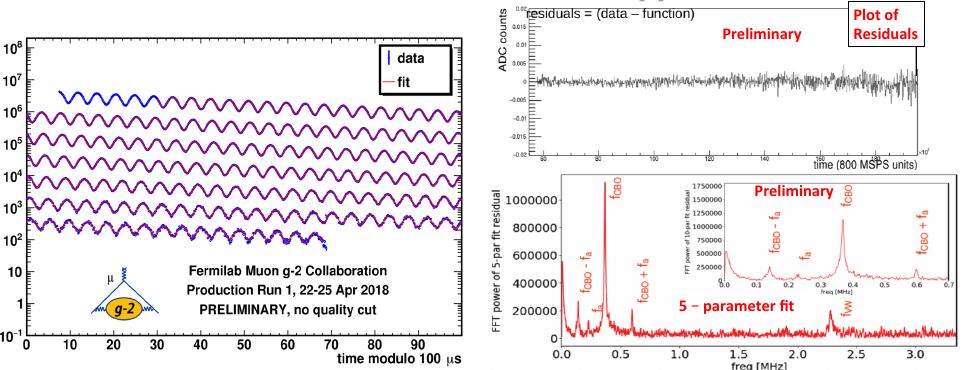
Figure 10. A fit to the modulated positron distribution with time ( Left ); a plot of the fit residual ( Top Right ); and a Fourier transform of the fit residual ( Bottom Right